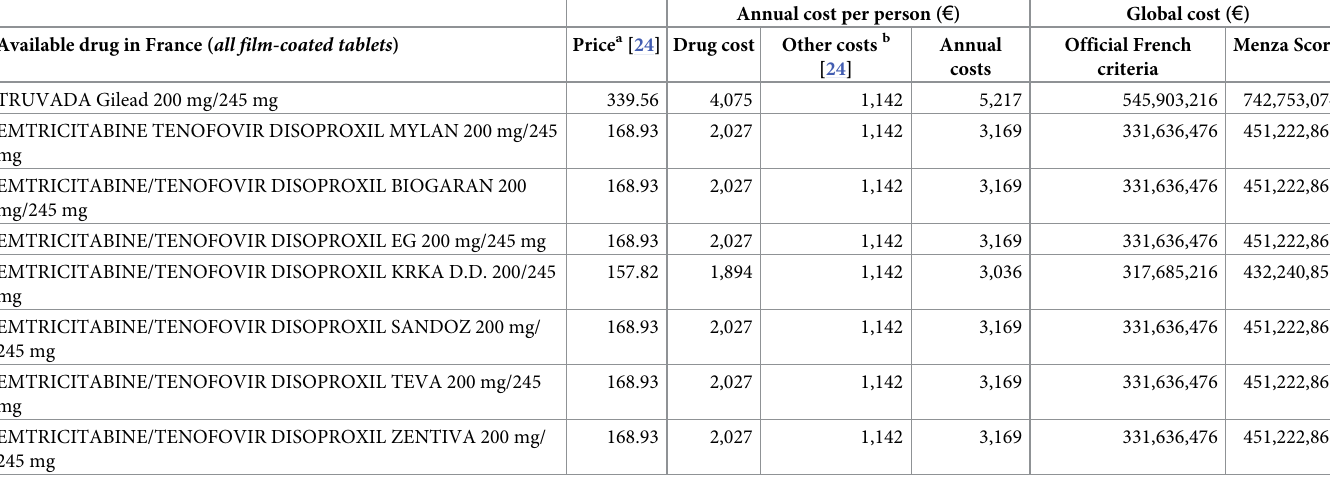
Table 4. Estimation of annual cost of rolling out PrEP to all eligible MSM in France in 2019.